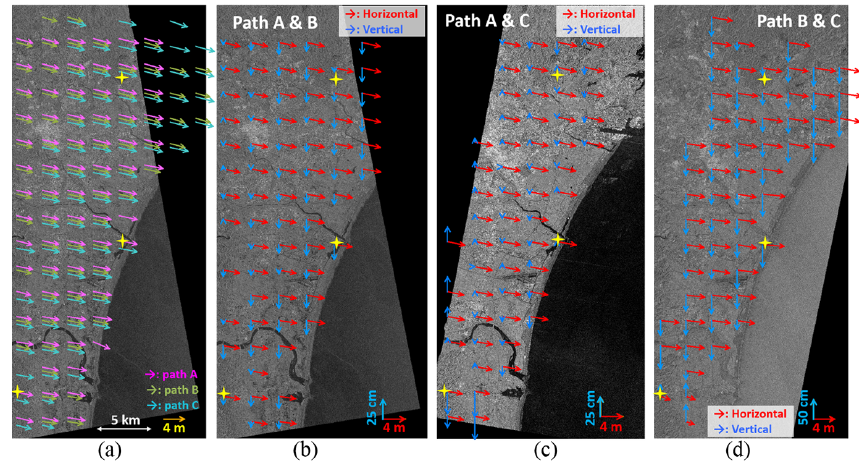
Figure 6. (a) Detected 2-D displacement vectors in each sub-area plotted on the pre-event TSX image from path A (the top, middle, and bottom vectors represent the results from paths A, B, and C respectively). (b–d) Estimated displacement vectors in each sub-area from the pairs of paths A and B, A and C, and B and C, plotted on the pre-event TSX image.